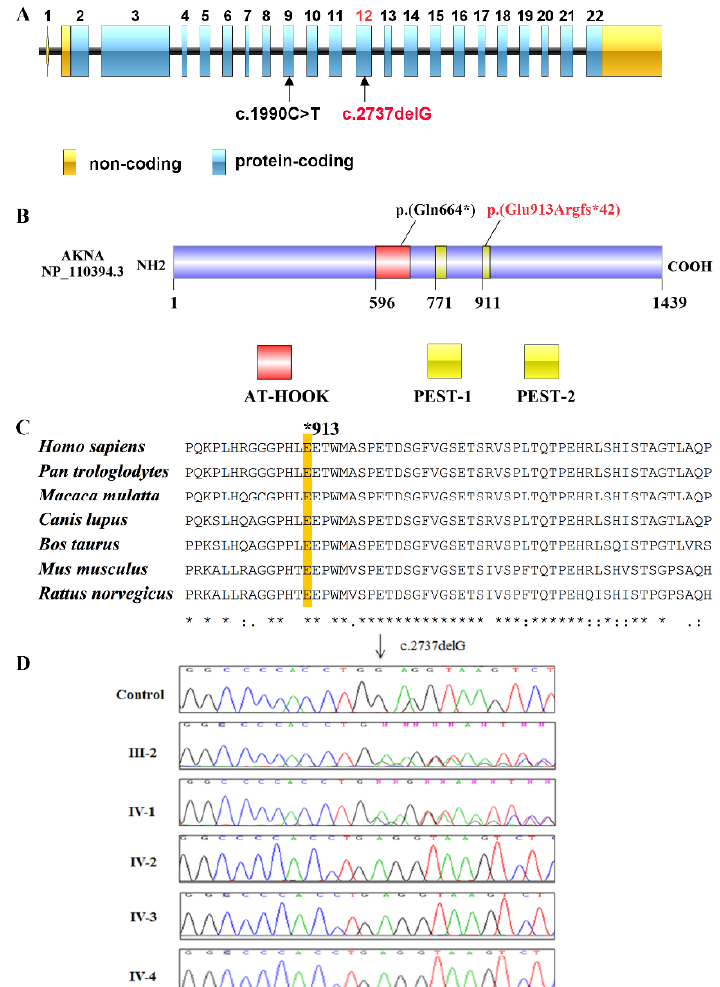
Figure 3. Identification of a homozygous variant in AKNA . ( A ) Schematic representation of the AKNA gene structure . All exons (boxes) are drawn to scale and separated by lines of arbitrary length to delineate the introns (Illustrator for Biological Sequences (IBS) v 1.0.1). The novel variant was identified in exon 12. Previously, a variant in exon 9 had been found and tentatively associated with PCD [16]. Blue boxes indicate the coding part while yellow boxes represent the untranslated regions at the 3 ′ and 5 ′ ends. ( B ) Schematic representation of the AKNA protein structure comprising 1439 amino acids. Domains are highlighted by the specified color code; the yellow color is presenting the proline (P), glutamic acid (E), serine (S), and threonine (T) (PEST) domains. The novel truncating variant p.(Glu913Argfs*42) is located at the start of the second PEST domain. The red color marks the AT-hook-containing transcription factor domain (AT-hook). A variant in that domain, p.(Gln664*), has recently been reported to be associated with PCD and to cause sinopulmonary infections [16]. ( C ) Multiple sequence alignment of human AKNA homologous proteins. Most of the miscoded amino acids in the truncated protein at and after position Glu913 are strictly conserved in verte- brates. The alignment was performed with Clustal Omega. Protein accession numbers from NCBI are as follows: NP 110394.3_ H. sapiens , XP_003312312.2_ P. troglodytes , XP_001096711.2_ M. mulatta , XP_538809.3_ C. lupus , XP_002689997.3_ B. taurus , NP_001038979.1_ M. musculus , NP_001102138.1_ R. norvegicus. ( D ) Sanger sequence electropherograms of all available family members and a control to document co-segregation between the congenital microcephaly phenotype and the recessive disease allele. As expected, all patients are homozygous for NM_030767.4:c.2737delG in exon 12 of AKNA whereas the father and the normal sibling are heterozygous carriers of the mutant